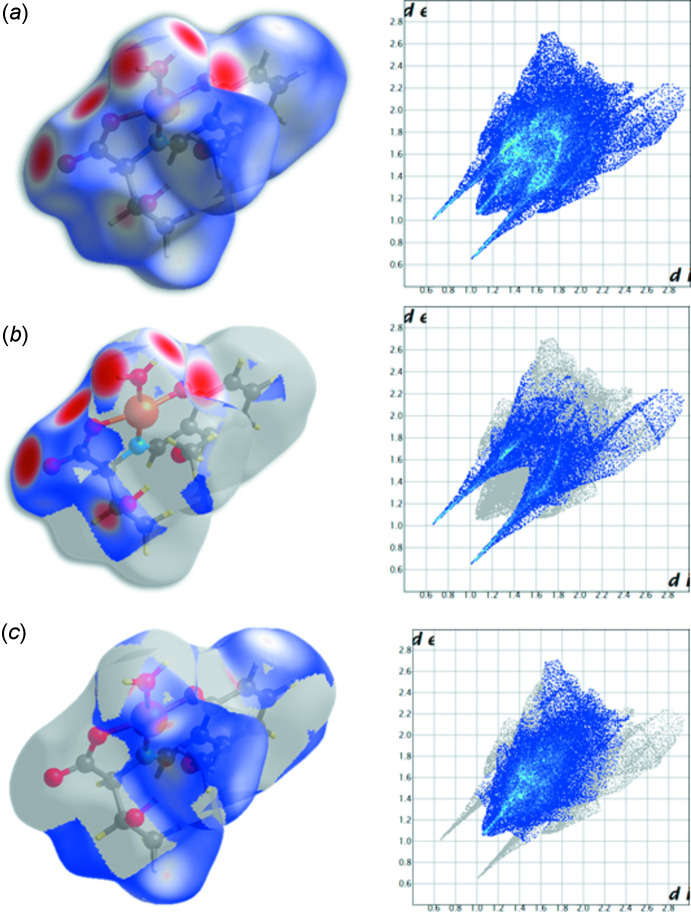
Hirshfeld surfaces mapped over d
norm (left) and two-dimensional fingerprint plots (right), showing (a) all inter­actions, and delineated into (b) H⋯O/O⋯H and (c) H⋯H contacts. d
e and d
i represent the distances from a point on the Hirshfeld surface to the nearest atoms outside (external) and inside (inter­nal) the surface, respectively.